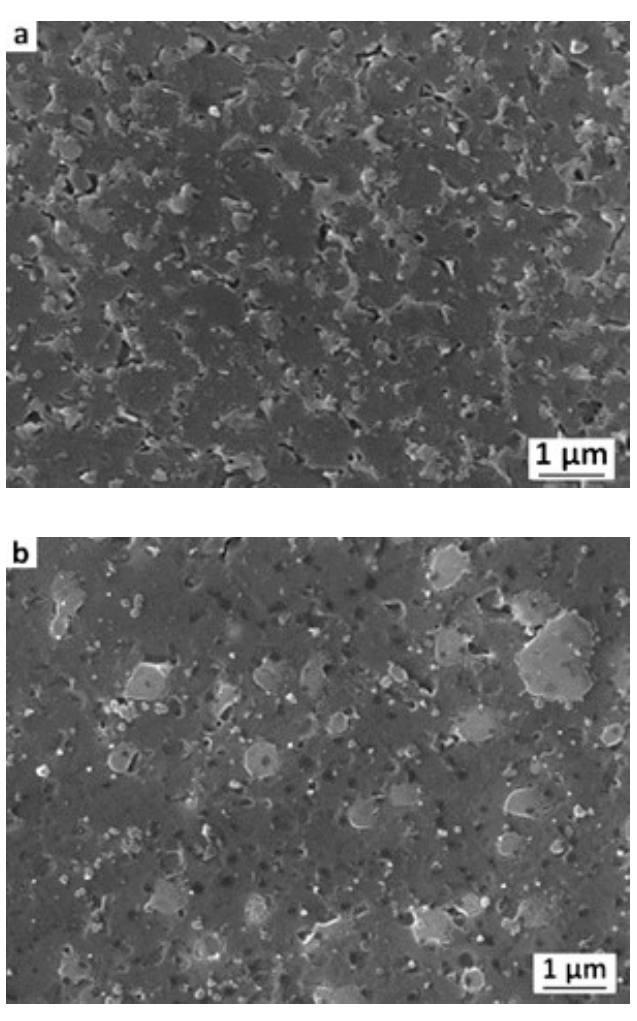
Figure 7. SE-SEM images of artificially-aged ( a ) as-built and ( b ) solution treated samples after Keller’s